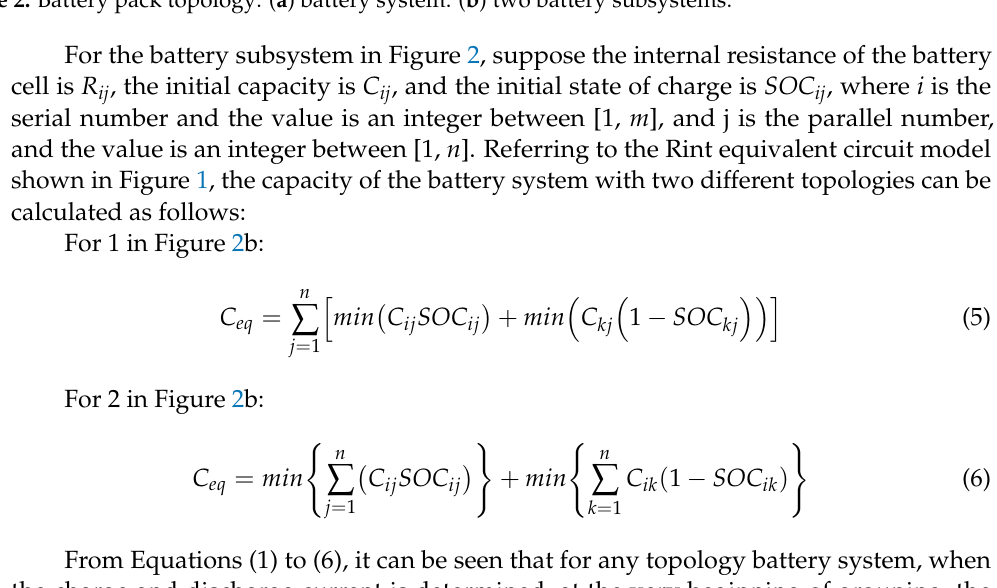
Figure 2. Battery pack topology: ( a ) battery system. ( b ) two battery subsystems.